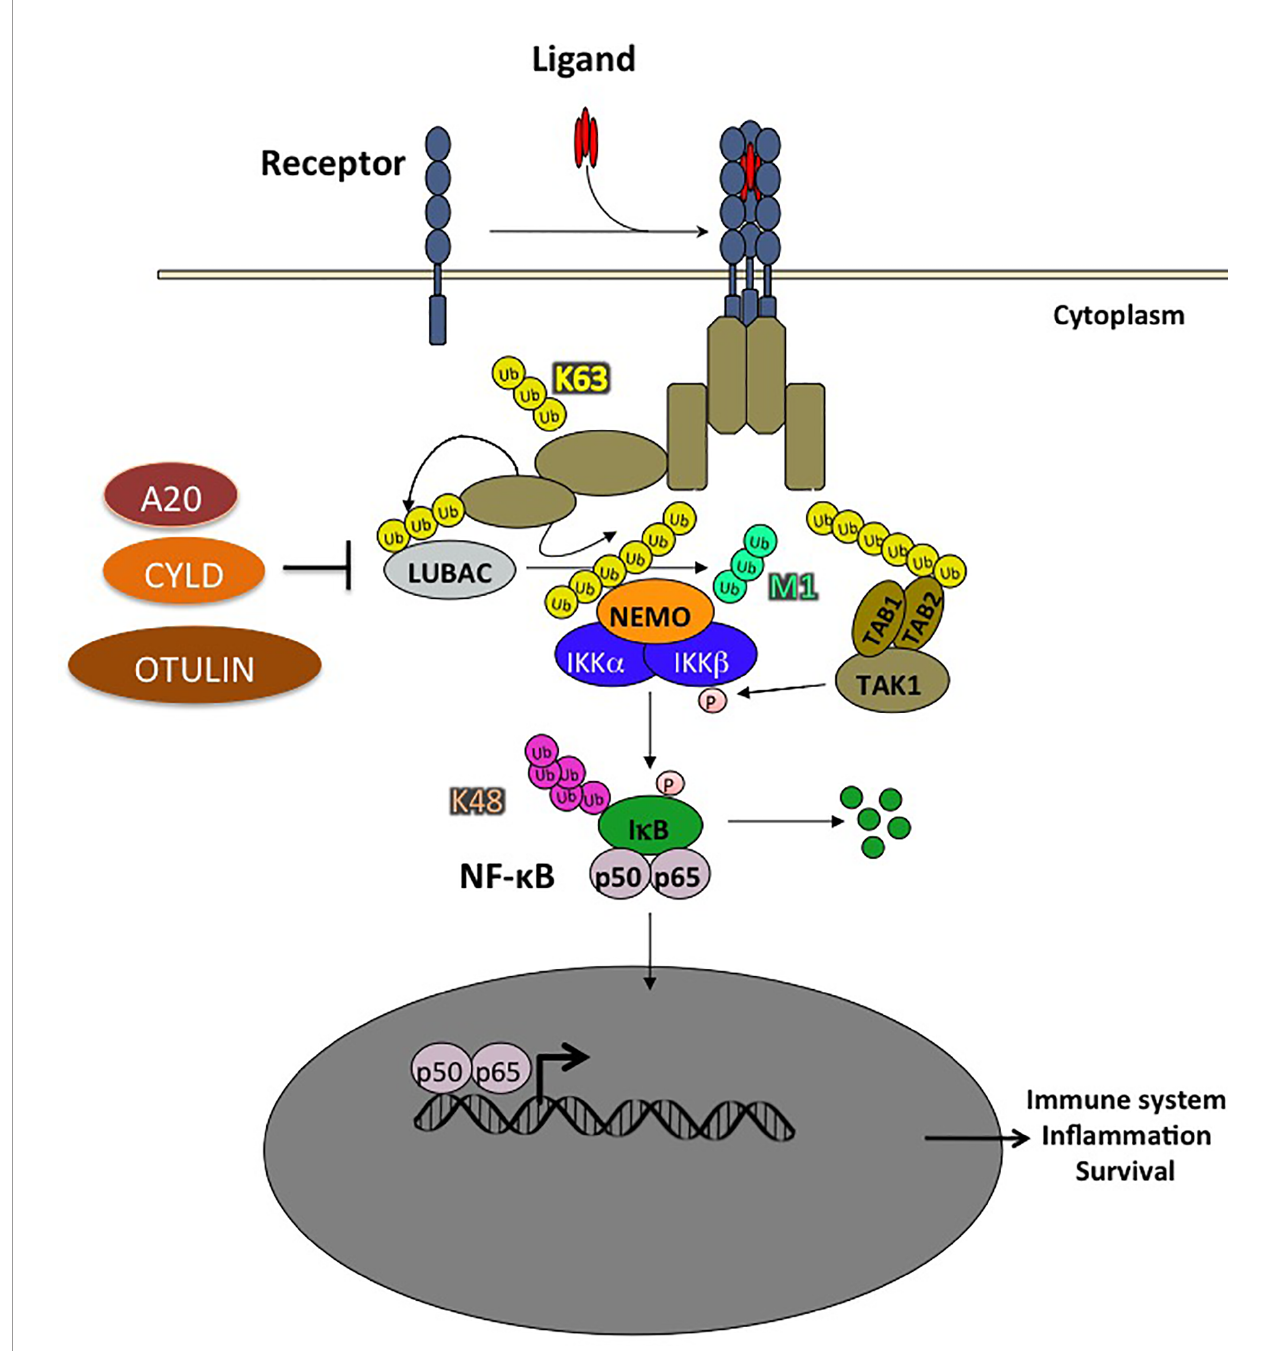
FIGURE 3 | Ubiquitination plays a crucial role in NF- k B activation pathways. The ubiquitination of a substrate can take place with a single ubiquitin (monoubiquitination) or a chain of covalently linked polyubiquitin molecules (polyubiquitination). In the NF- k B pathway, the NF- k B inhibitor, I k B, is modi fi ed by K48- linked polyubiquitin chains which are recognized by the 26S proteasome, leading to the degradation of these proteins and the translocation of NF- k B into the nucleus. The polyubiquitin chains linked through the Lysine K63 of ubiquitin do not trigger the degradation of proteins, but rather have non-proteolytic functions such as protein traf fi cking or activation of kinases and phosphatases. In addition, ubiquitin chains can also be linked linearly, the C-terminal glycine being linked to an N- terminal methionine. Two RING type E3 ligases, HOIL1 and HOIP, speci fi cally assemble linear polyubiquitin chains which play an important role in the regulation of NF- k B. Other types of ubiquitin modi fi cations have also been observed but are not presented in this schema. Ubiquitination is reversible and counter-regulated by a family of deubiquitinases (DUB). There are 3 DUBs playing an important role in the negative regulation of the NF- k B pathway: A20, CYLD and OTULIN, the latter cleaving exclusively linear ubiquitin